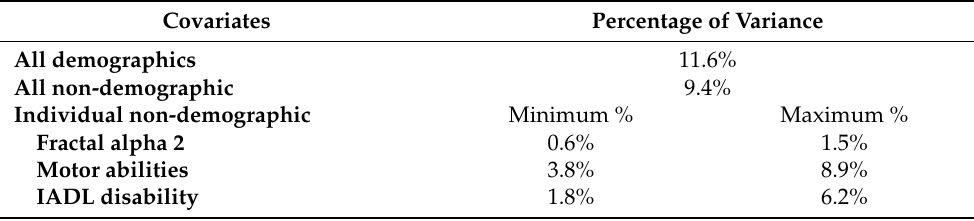
Table 4. Variance of Declining Total Daily Physical Activity Explained by Key